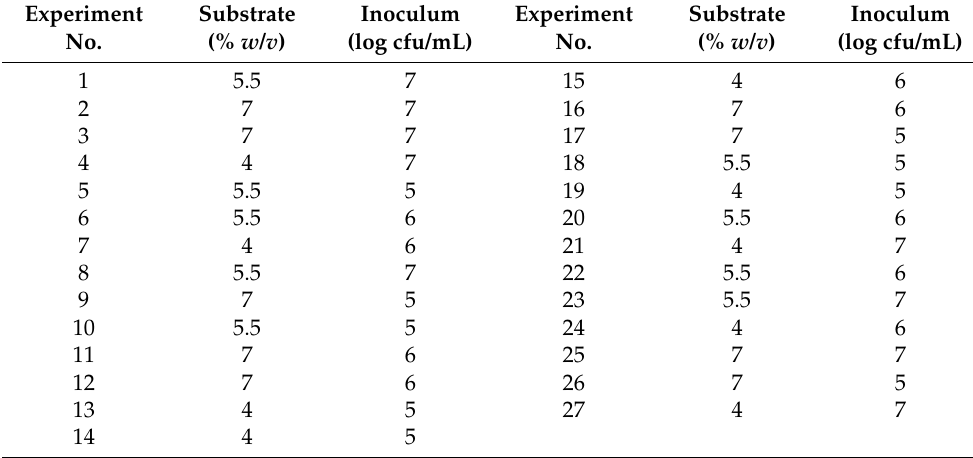
Table 1. Completely randomized design experiments for two factors with three